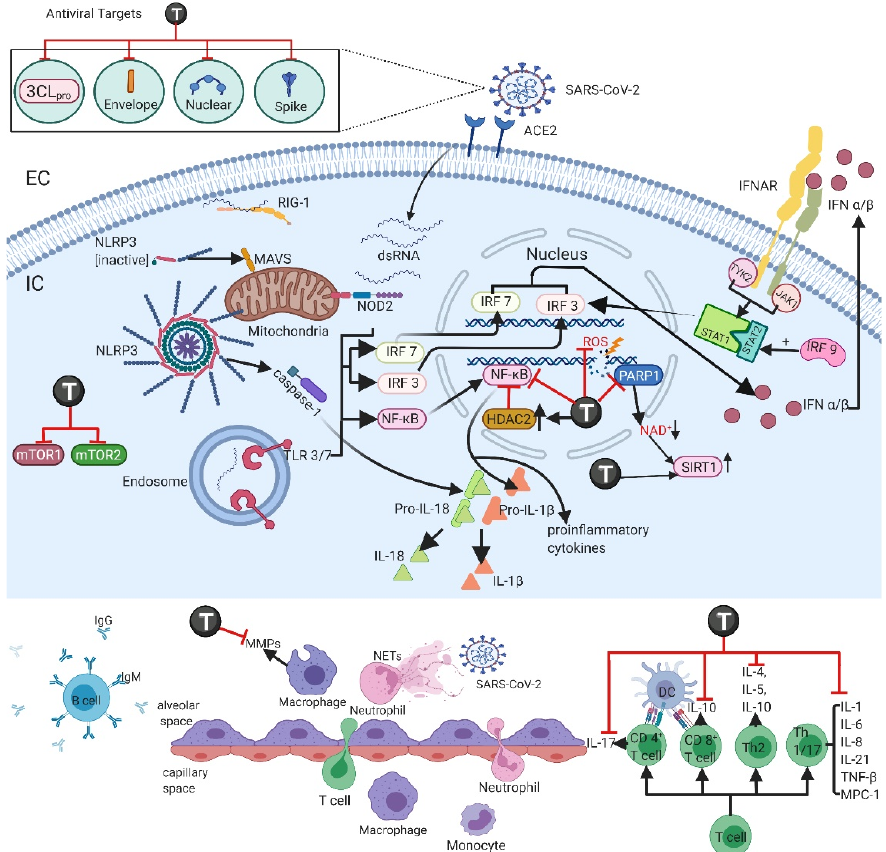
Figure 1. SARS-CoV-2 enters the cell through ACE2 found in the membrane of type II pneumocytes. The immune response is initiated through the activation of PRRS (TLR, NLR, RIG-1) located in the membrane and cytosol interacting with the viral RNA. The stimulation of these receptors leads to the activation of transcription regulating factors such as IRF 3/7 and NF-kB, which leads to the production of interferons type I/III and other pro-inflammatory cytokines. Theophylline modulation of HDAC2 inhibits NF-kB and inflammatory genes. DNA damage produced by ROS production activates PARP1, which leads to NAD + depletion, decreasing SIRT1 activity. Theophylline inhibits PARP1, decreases ROS production, and enhances SIRT1 expression and activity. mTOR inhibition by theophylline contributes to attenuating the inflammatory response. The production of these cytokines initiates the recruitment of neutrophils and recruitment and differentiation of monocytes into alveolar macrophages. The cytokine storm microenvironment produced as a result of the viral infection stimulates the activation and differentiation of cytotoxic CD8 + and helper CD4 + T cells necessary for viral clearance, initiating the production of cytokines, recruitment of monocytes and neutrophils, promoting the immune response. The proposed antiviral effects of theophylline are highlighted. In order to successfully limit the viral infection in later phases of the disease and to prevent future reinfections, the participation of the humoral response and production of antibodies is